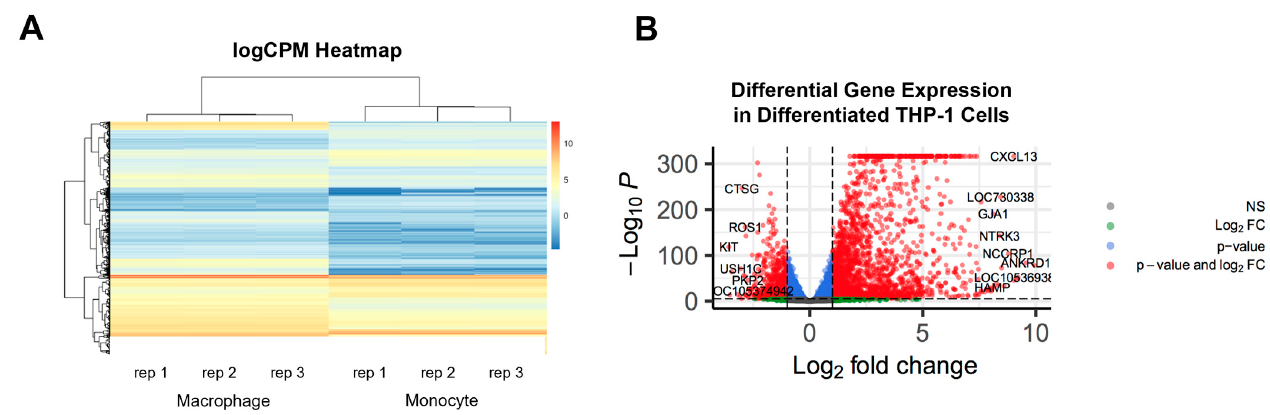
Figure 1. ( A ) Heatmap of log Counts Per Million (logCPM) of genes found in common between the THP-1 cells before and after differentiation (monocytes to macrophages). Replicates (rep) refer to the biological replicates. ( B ) Volcano plot of differentially expressed genes (DEGs) in differentiated macrophages compared to monocytes. All genes shown as dots. Significantly DEGs ( p < 0.05) are colored above the horizontal line. Genes with DGE > |1| are shown in red left and right of the vertical lines. Genes are only labeled with p < 0.001 and FDR < 0.001.